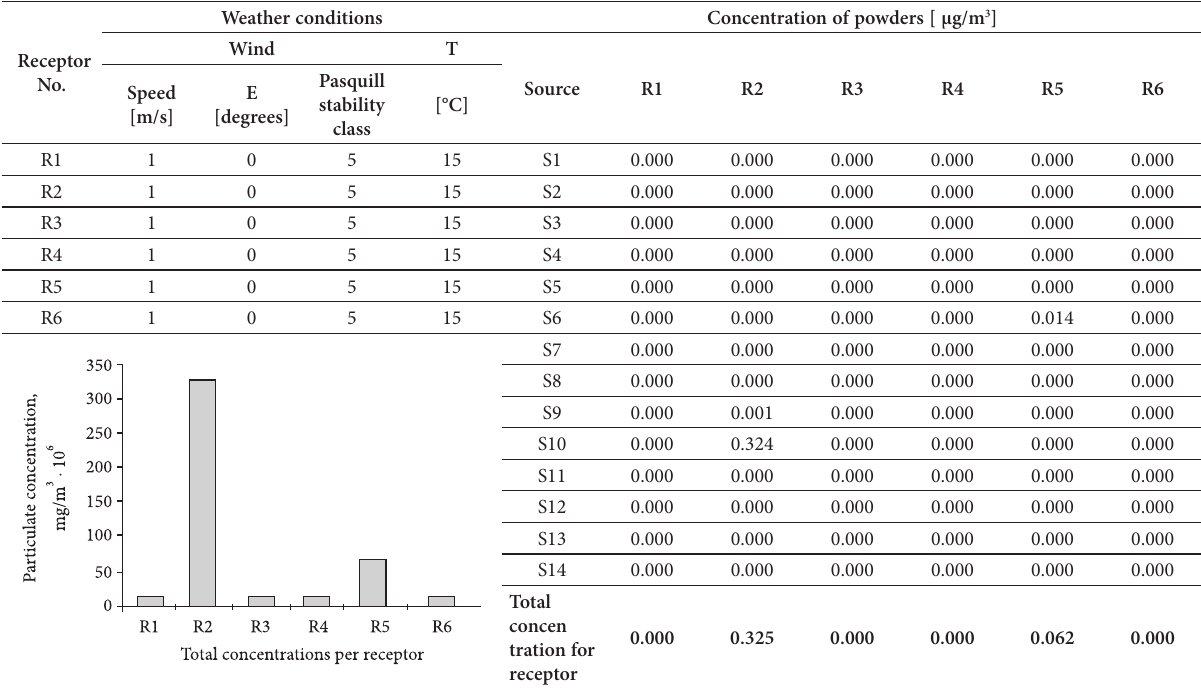
Fig. 3. Data and graphic representation for distribution of powders emissions from 14 sources in atmospheric condition “highly